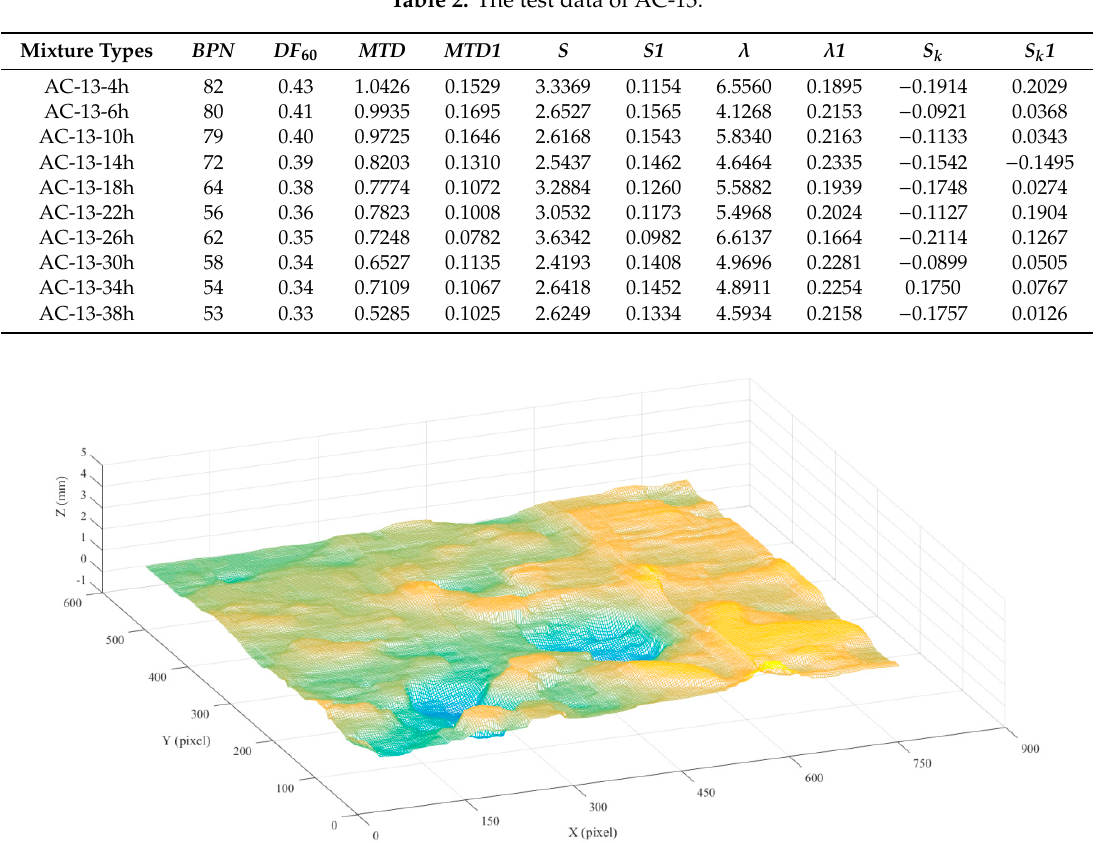
Table 2. The test data of AC-13.